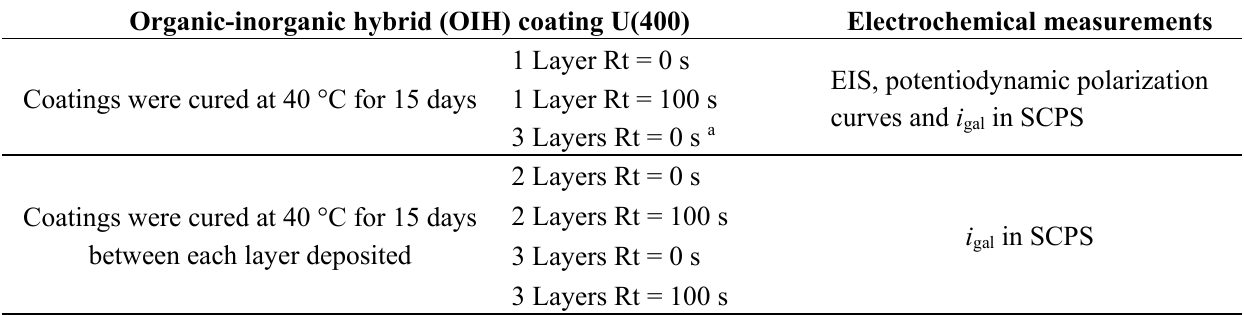
Table 1. Preparative conditions and electrochemical measurements performed in each coating. Organic-inorganic hybrid (OIH) coating